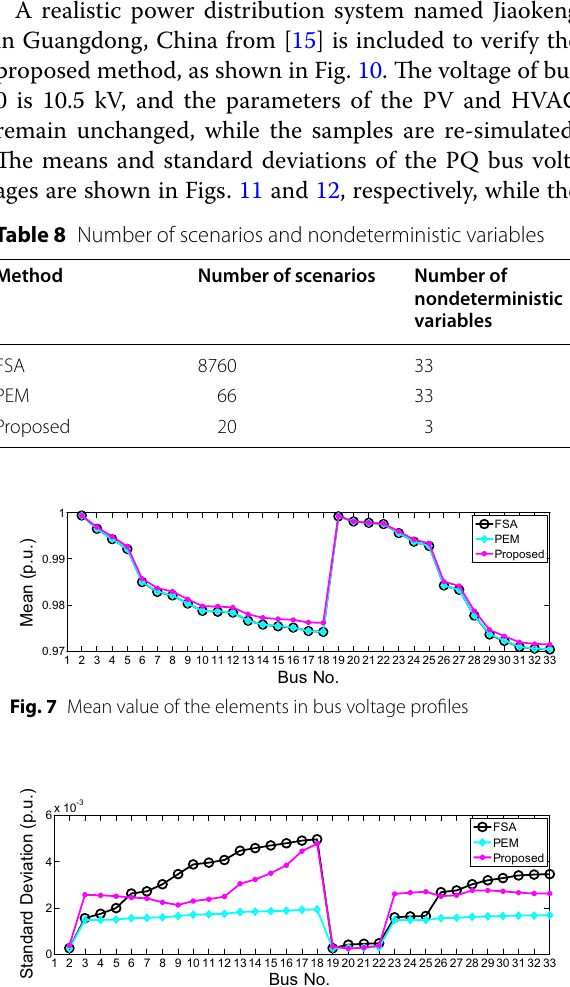
Fig. 9, the curve of the proposed method is close to the curve of the real results, while the curve of the PEM in \* MERGEFORMAT [24] is significantly biased.